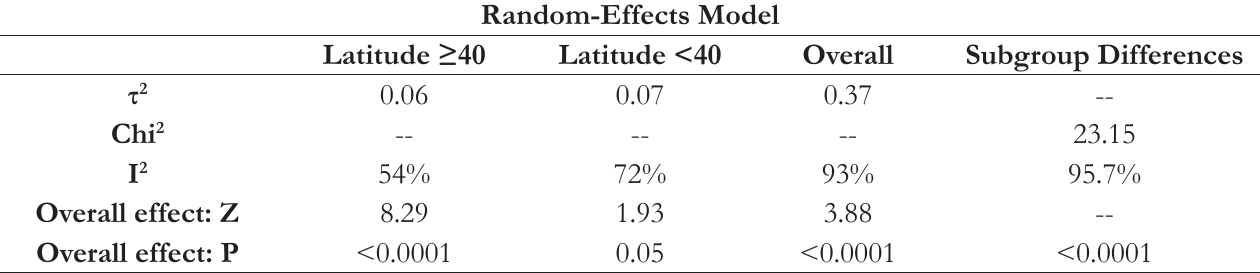
Table 3. Random-effects Model